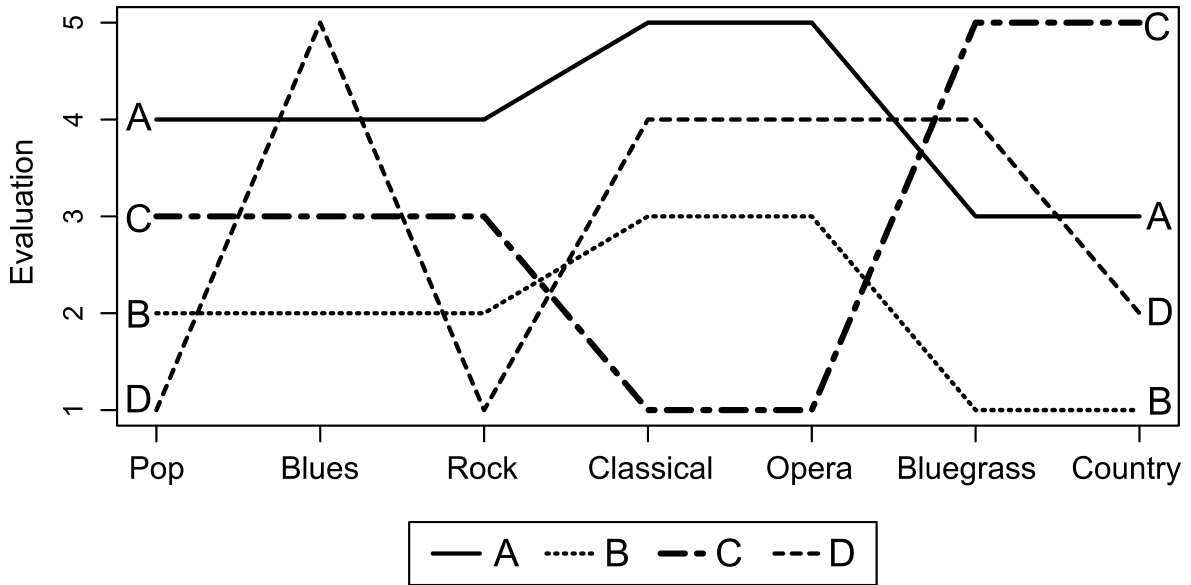
Figure 1: Musical tastes of four respondents, with evaluations ranging from 1 (strongly dislike) to 5 (strongly like) for each genre. Respondents A, B, and C follow the same taste schema, whereas D does not. This figure recreates the contents of Goldberg’s Figure 1A